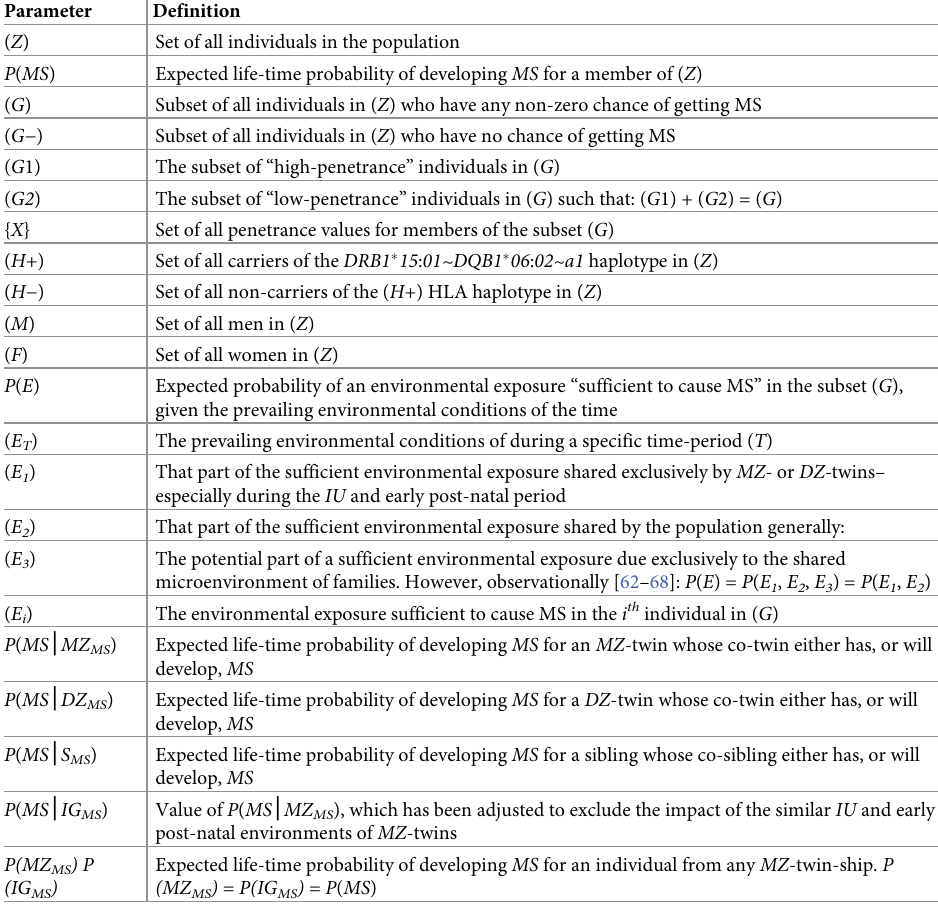
Table 1. Definitions for epidemiological parameters used in the